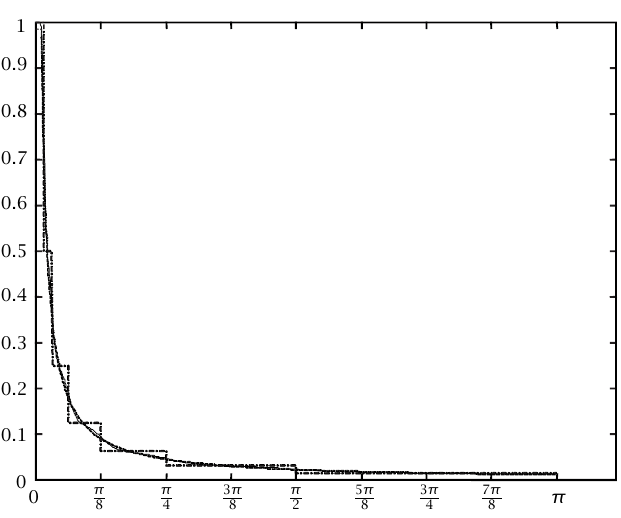
Figure 2: Magnitude of the DTFT of the discrete-time scaled wavelets and order 4 scaling sequence based on Daubechies filters of order 11